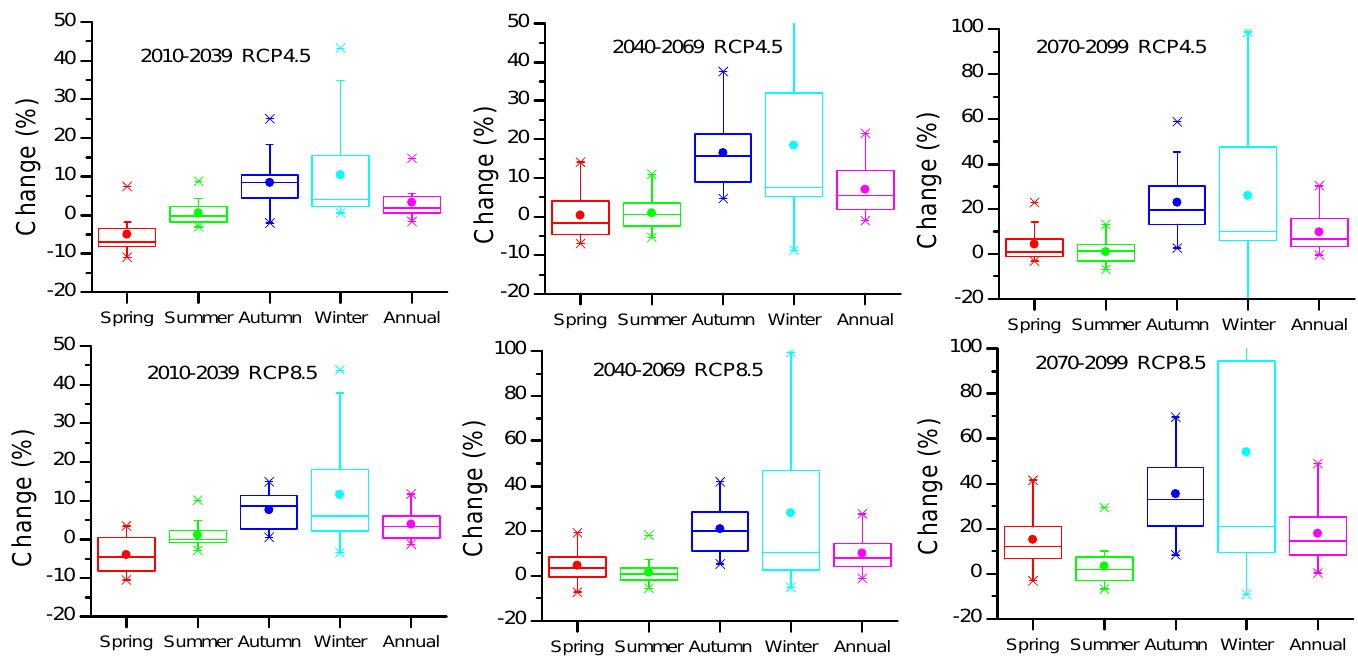
Figure 11. Boxplots for percentage change of future ET 0 related to the period 1961–2005 at seasonal and annual scales.